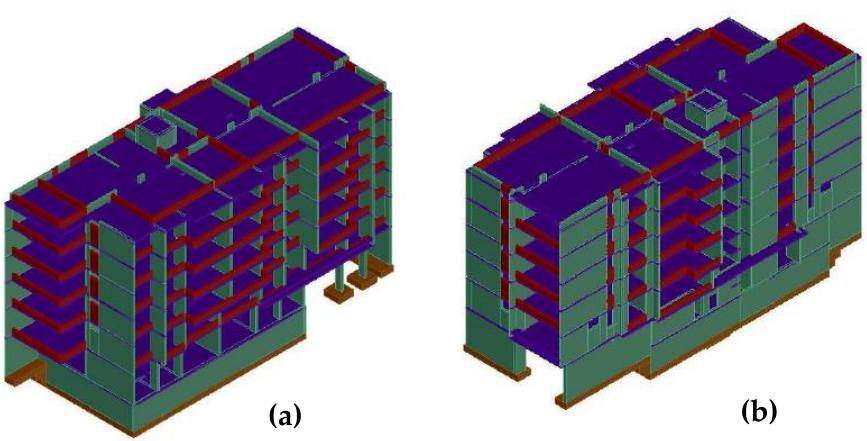
Figure 3. Elevation view of the section of the building in axis B.